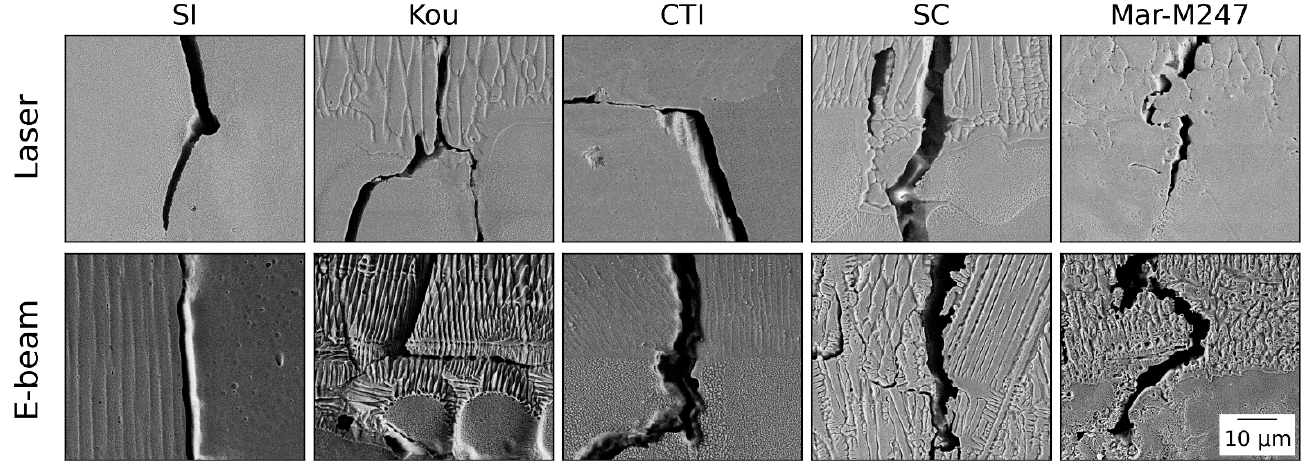
Figure 6. SEM micrographs of cracks in experimental alloys and reference Mar-M247 alloy from laser melting ( top row) and electron beam melting ( bottom row) experiments. All micrographs share the same scale bar.